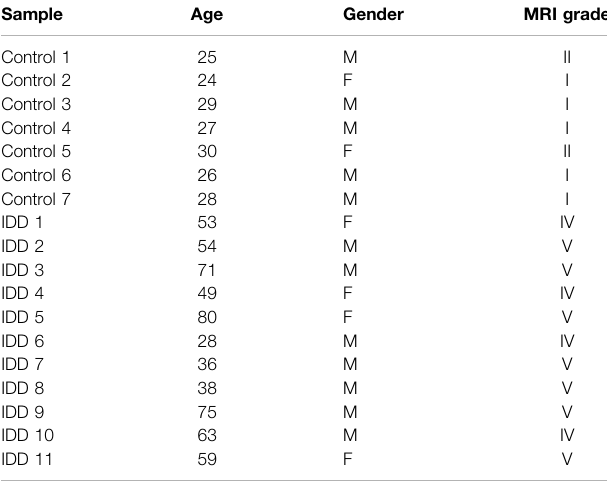
TABLE 1 | Basic information of the